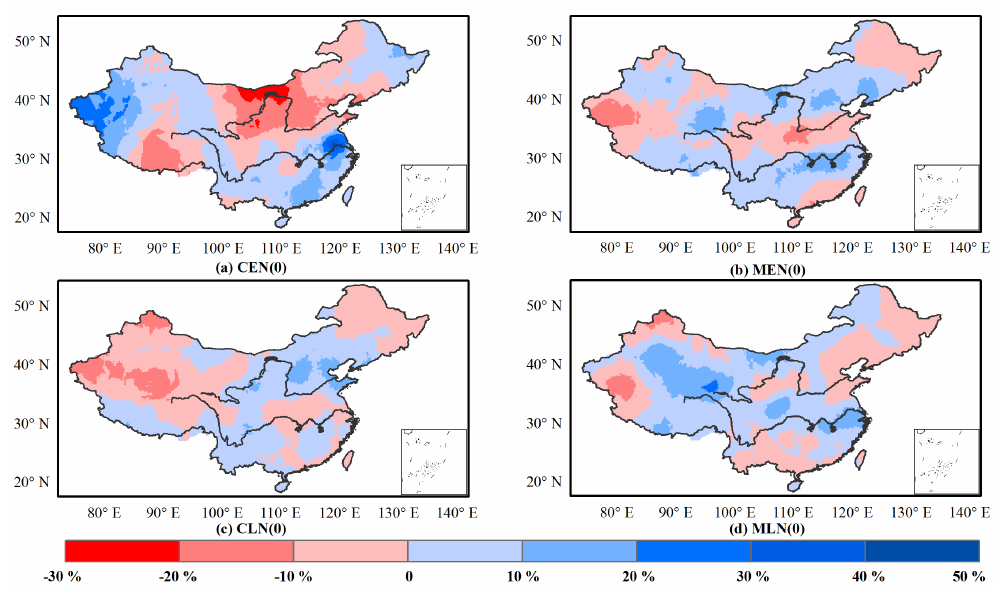
Figure 3. Spatial pattern of precipitation anomalies during rainy season (PARS) during developing (0) conventional ENSO and ENSO Modoki